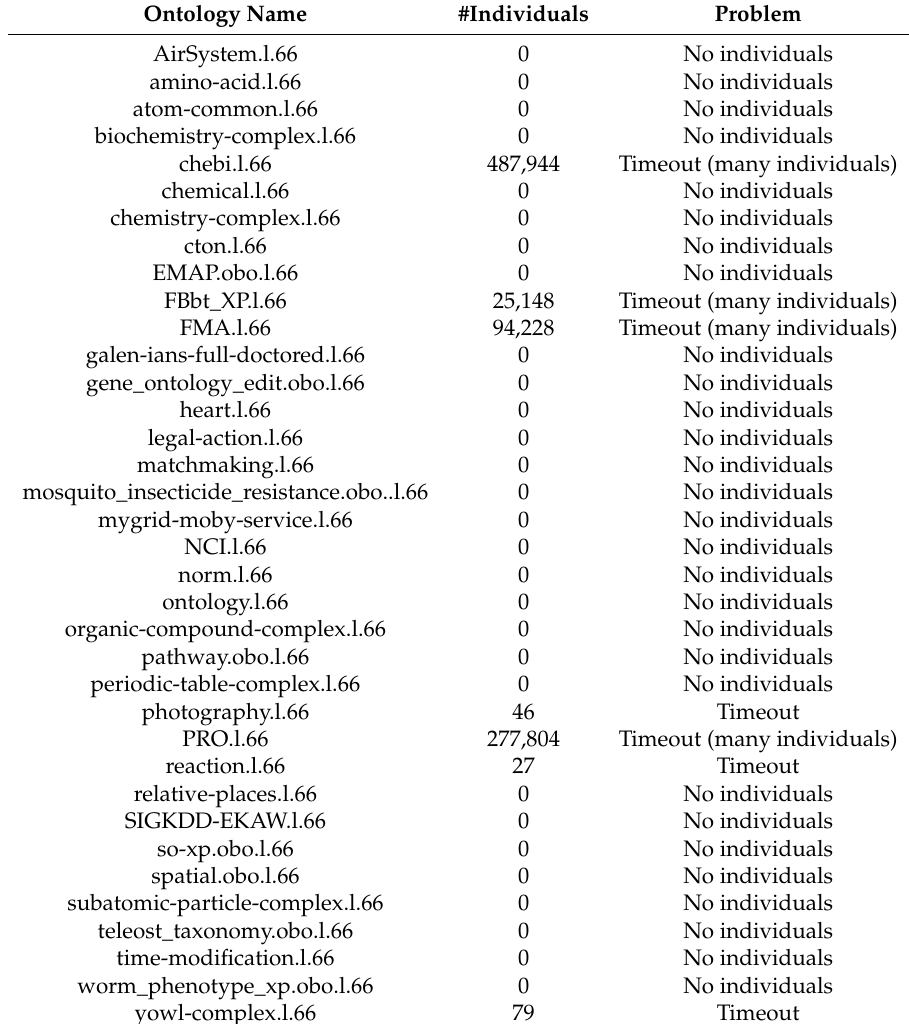
Table 7. Problems found in the Absorption